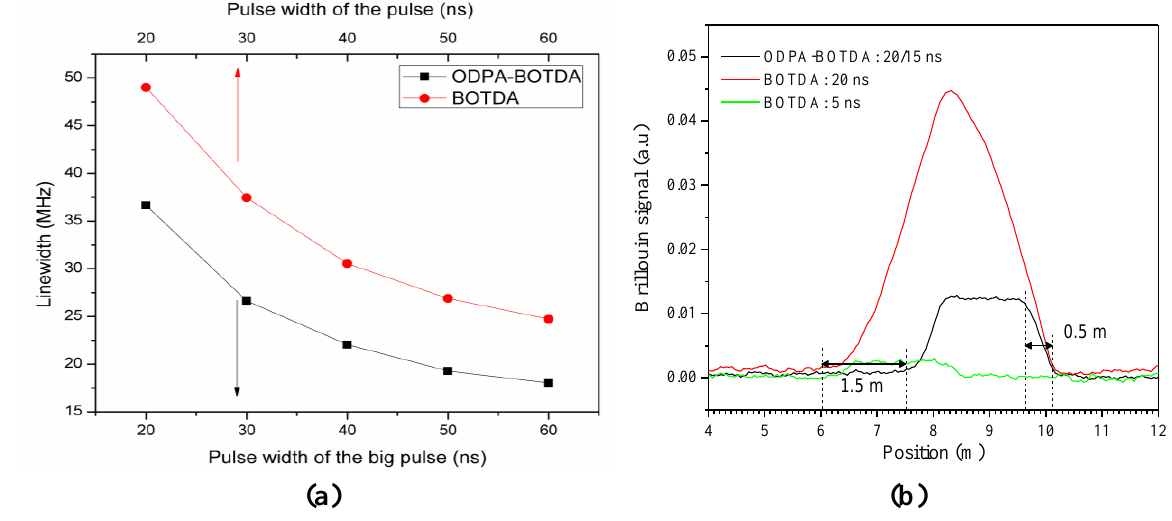
Figure 10. Brillouin spectrum width of the BOTDA (20–60 ns pulse) and the ODPA-BOTDA sensor with 20/18 to 60/58n s pulse pair based on Equation (20) (a, left); time domain signal of ODPA-BOTDA vs. BOTDA (b, right) [45] (Copyright © 2010 OSA, Reprinted with